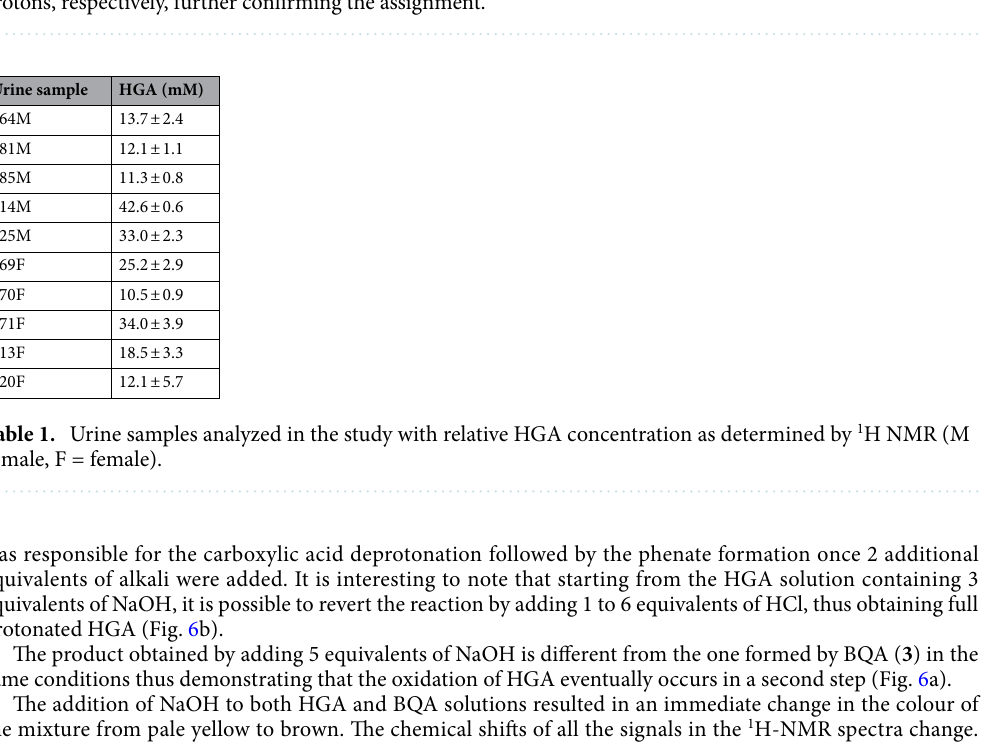
Figure 2. 13 C spectrum (top) of the same AKU patient urine sample shown as 1 H spectrum in Fig. 1; the bottom spectrum is APT with positive and negative peaks for carbon bearing an even or odd number of protons, respectively, further confirming the assignment.